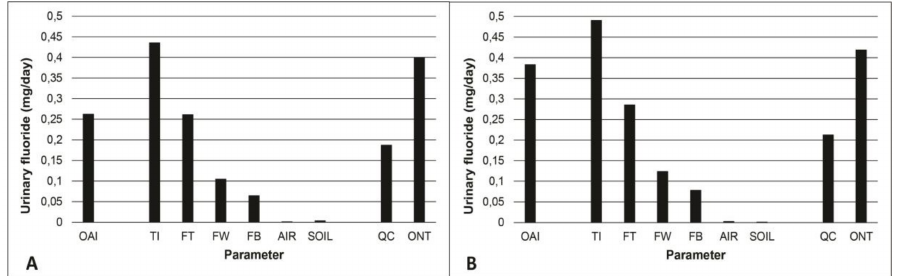
Figure 5. Modelled excreted fluoride over 24 h at a steady-state, according to the different intakes considered in the 4-year-old ( A ) and 8-year-old ( B ) child. The data from Table 2 were used for fluoride sources. These modeled data are compared to CHMS biomonitoring geometric mean data for cycles 2 and 3 combined for Quebec (QC) and Ontario (ONT) for children aged 3–5 years-old ( A ) and 6–11 years-old (B) . Symbols: OAI: suggested Optimal absorbed intake of 0.04 mg/kg/day. TI: Total (absorbed) intake. FT: Fluoride toothpaste. FW: 0.07 mg/L fluoridated water. FB: Food and